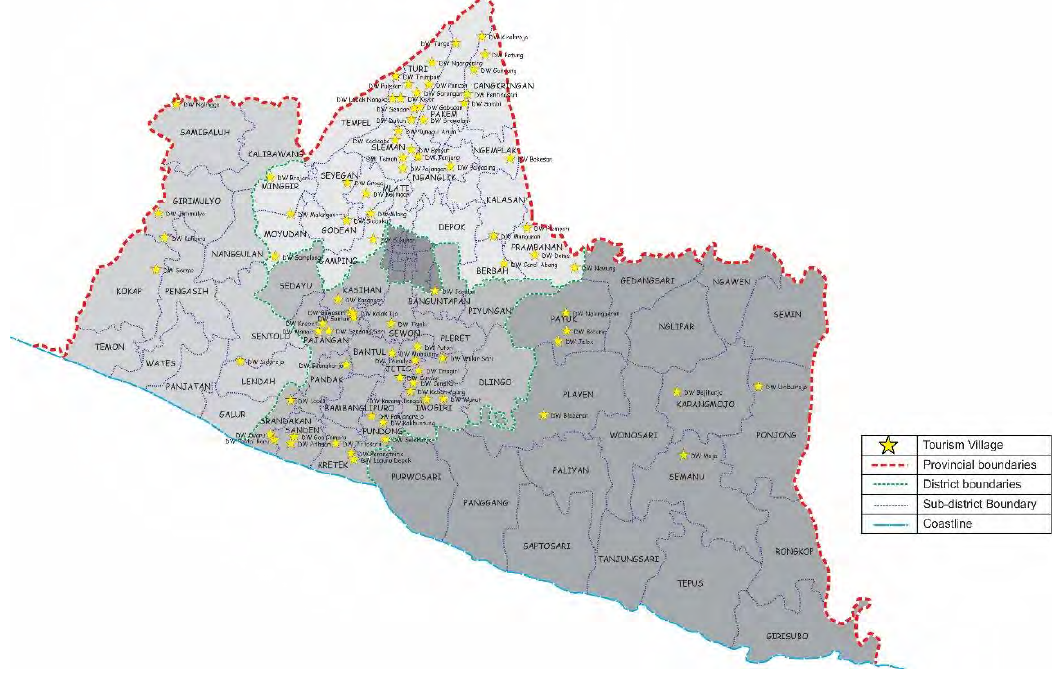
Figure 2. Map of Tourism Villages Distribution in Yogyakarta (author,